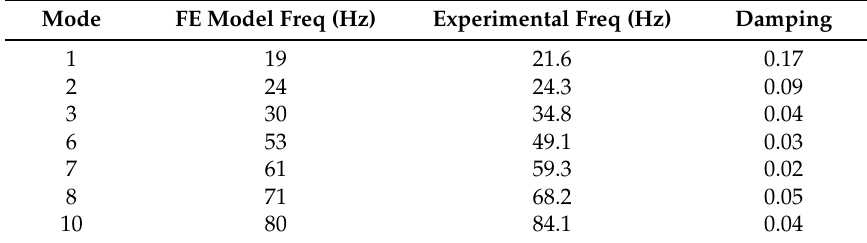
Table 3. Comparison between experimental and numerical mode and frequencies. FE stands for Finite